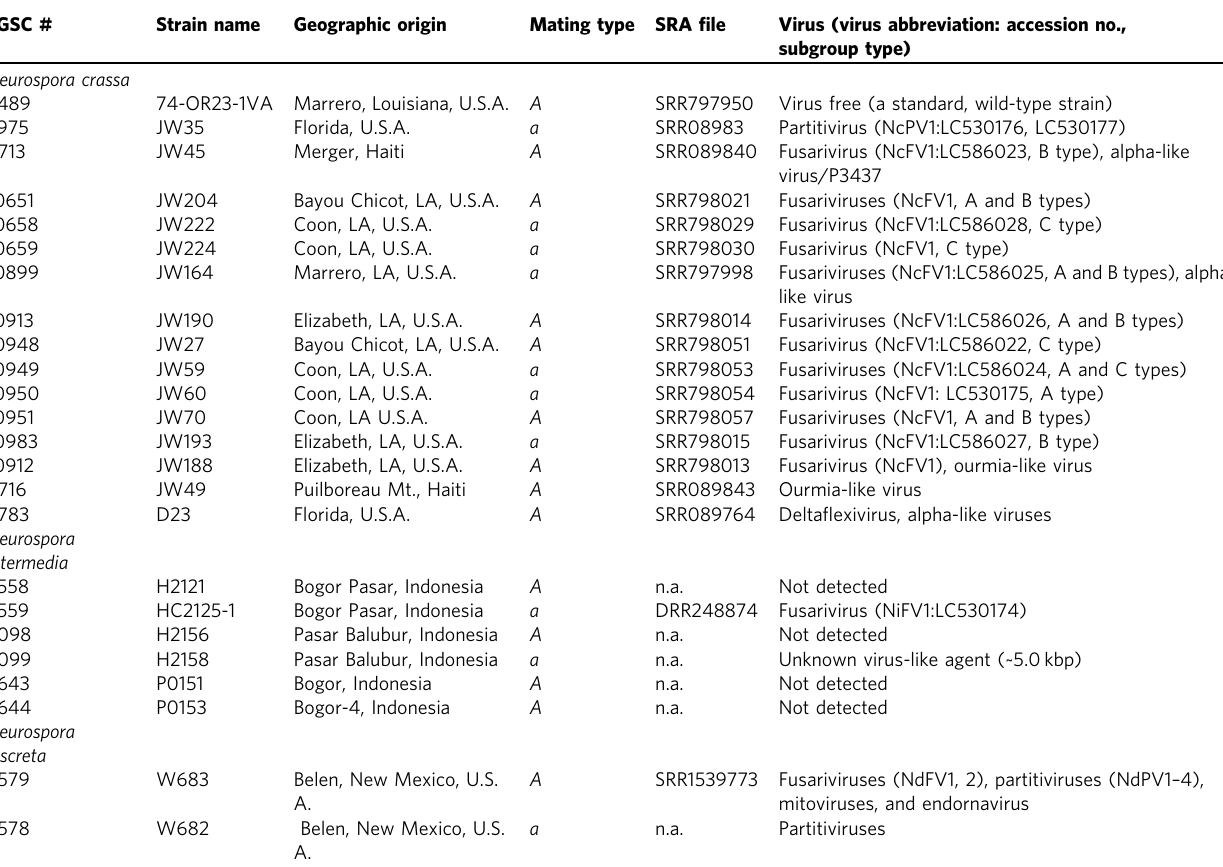
Table 1 List of Neurospora viruses and their host fungal